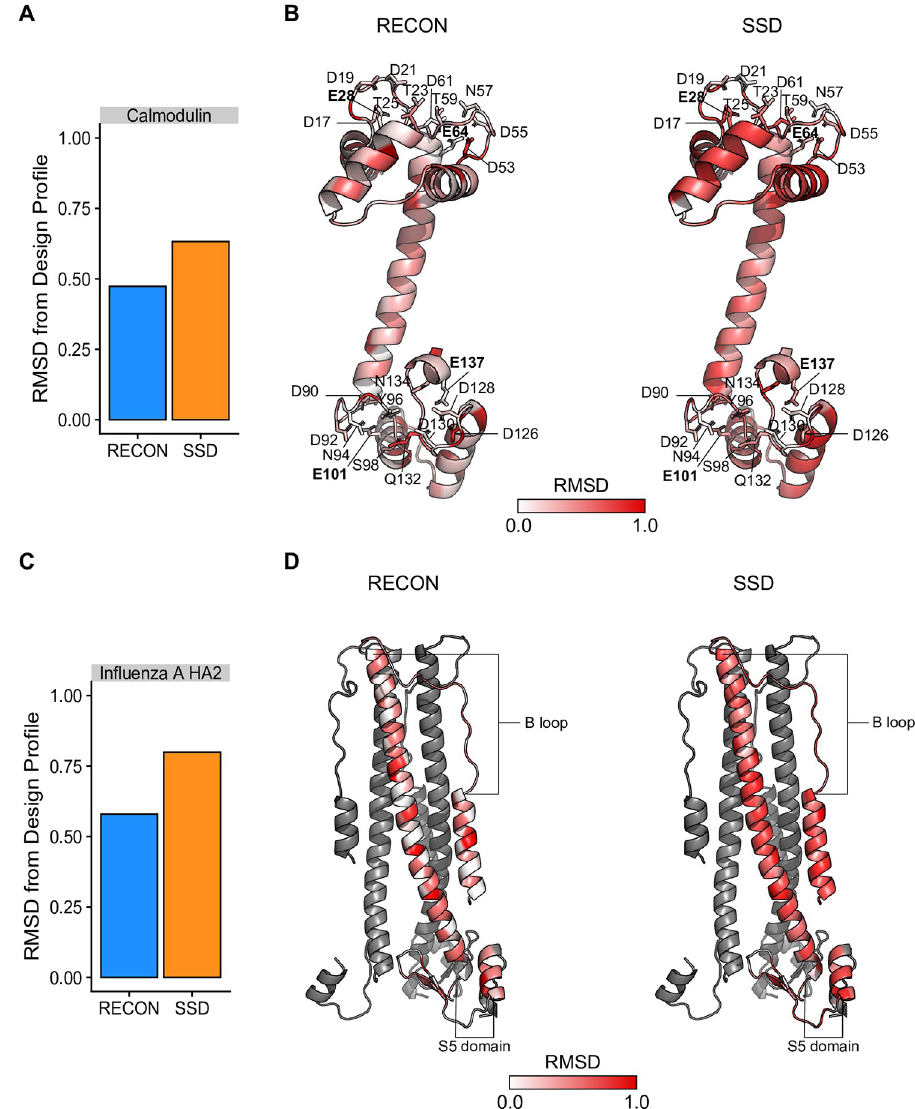
Fig 5. Comparison of mutation profiles predicted by protein design to mutation profiles observed within calmodulin and influenza type A HA2 multiple sequence alignments. (A) Comparison of root mean square deviation of mutation frequencies derived from calmodulin natural homologues to mutation profiles predicted by RECON MSD or SSD. Calmodulin natural homologue mutation preferences were derived from the multiple sequence alignment of calmodulin homologues. The root mean square deviation (RMSD) here represents the mean standard deviation of an individual residue’s mutation profile, consisting as the mean sum of squared differences of all twenty amino acid frequencies as determined by the multiple sequence alignment of calmodulin homologue sequences in relation to either RECON MSD or SSD residue profile. (B) Residue profile standard deviations between calmodulin multiple sequence alignment profiles and design profiles mapped onto the unbound conformation of calmodulin (PDB ID 1CLL). Here, RMSD represents the mean sum of squared differences of all twenty amino acid frequencies of each residue between homologue and design profiles. Residues whose sequence profiles were predicted to have identical mutation profiles as that within the corresponding position with the multiple sequence alignment are colored in white. The greater the dissimilarity between the homologue mutation profile and design profile, the greater the saturation in red, with complete saturation indicating an RMSD of 1.0. Residues within all four of the conserved EF- hand motifs are labeled, with the bidentate ligand at position 12 critical for Ca 2+ binding labeled in boldface. (C) Comparison of root mean square deviation of mutation frequencies derived from influenza type A sequence alignments to mutation profiles predicted by RECON MSD or SSD. RMSD is calculated in a similar fashion as in Panel A. (D) Residue profile standard deviations between HA2 multiple sequence alignment profiles and design profiles mapped onto the pre-fusion conformation of the HA2 trimer (PDB ID 2HMG). RMSD is calculated and labeled